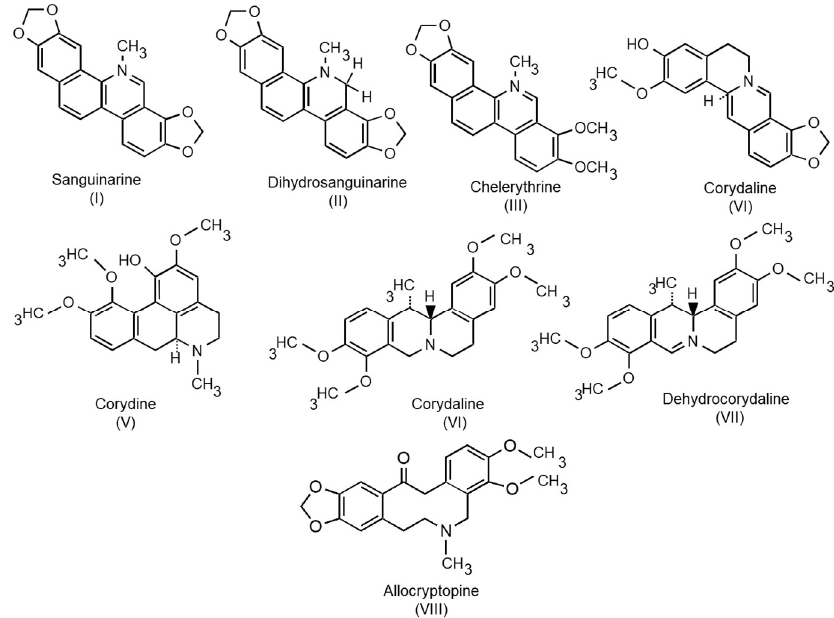
Figure 2. Chemical structure of the BZD analyzed in this review.